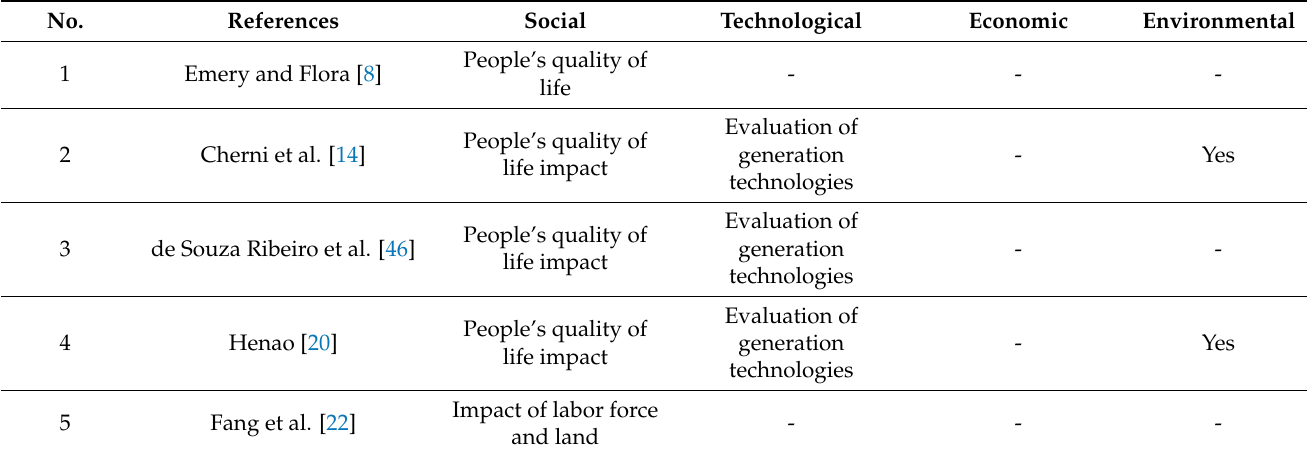
Table 5. Endogenous factors evaluated in energy planning models for remote